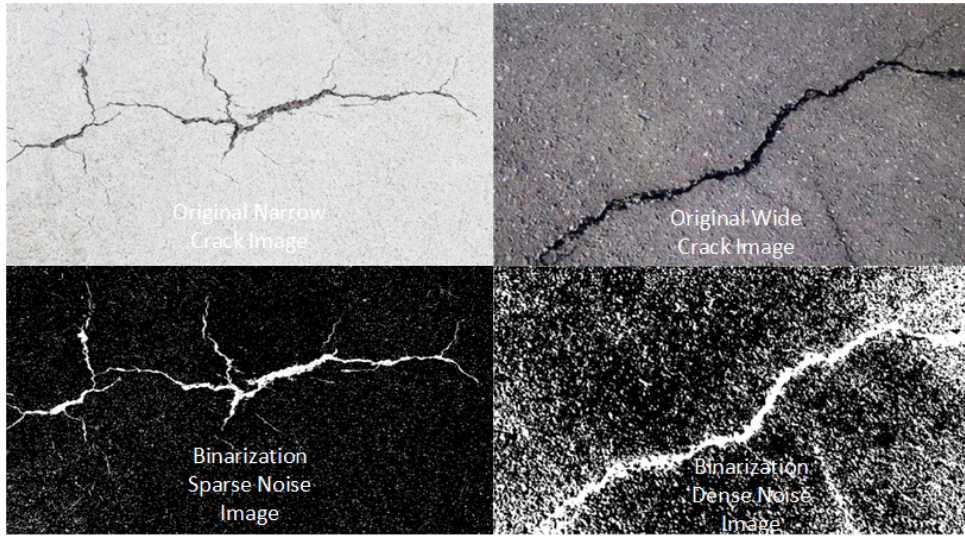
Figure 2. Camera image classification based on targeted filtering